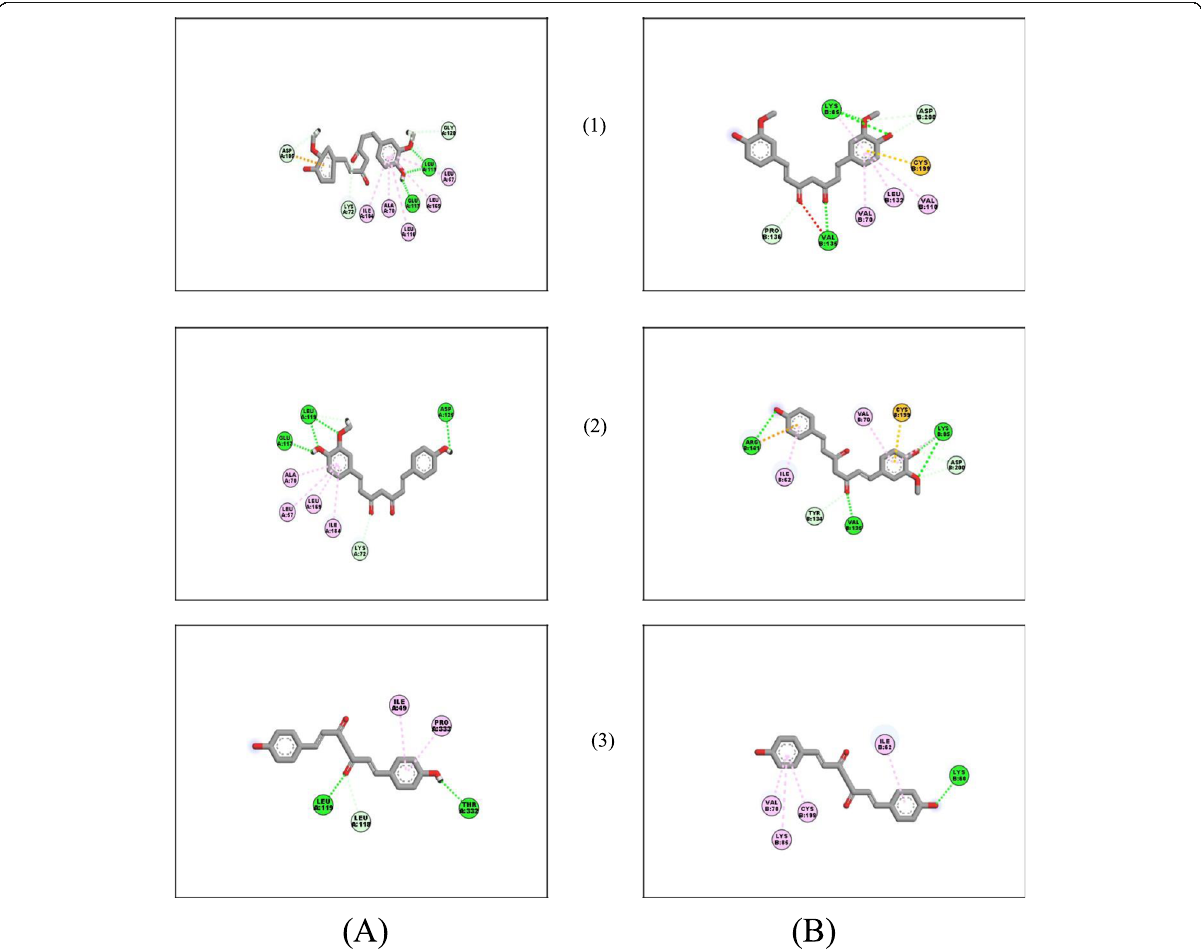
Fig. 5 2D representation of ligand-receptor interactions between (1) curcumin I (PubChem CID: 969516), (2) curcumin II (PubChem CID: 5469424), and (3) curcumin III (PubChem CID: 5315472) and ( A ) casein kinase-1 (PDB Id: 2IZS) and ( B ) glycogen synthase kinase-3 β (PDB Id: 3F88). Ligand is represented as a stick and interacting amino acid (labeled) of the receptor is represented as a disc sphere. The dotted line represents the type of interactions: dark green: hydrogen bond; light green: van der Waals interaction; pink: Pi-alkyl interaction; white: carbon-hydrogen bond; red: acceptor-acceptor interaction; orange: Pi-sulfur